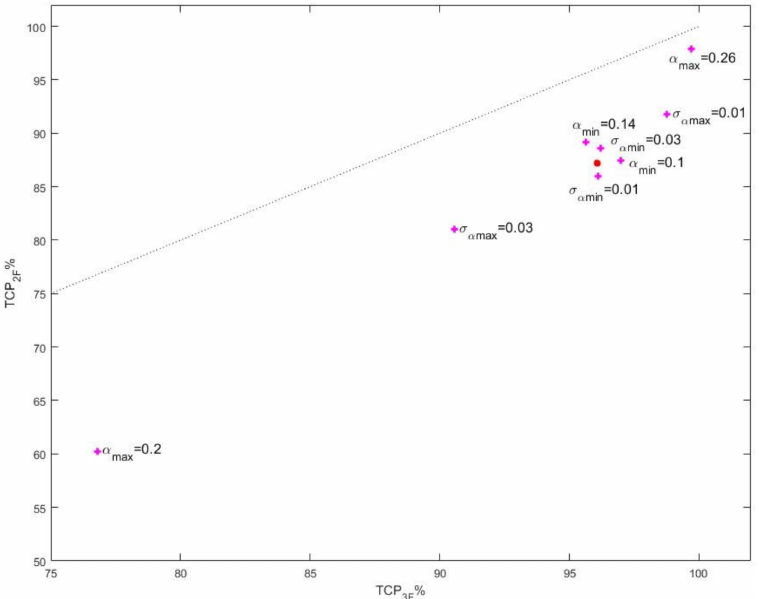
Figure 4. Illustration of the impact of different population radio-sensitivity parameter values on the predicted treatment outcome in terms of population TCP. TCP of the group treated with three fractions—axis X; TCP of the group treated with two fractions—axis Y. The solid red dot corresponds to the population TCPs calculated based on the parameter values from Equations (6) and (7). The varied parameter values are denoted in the